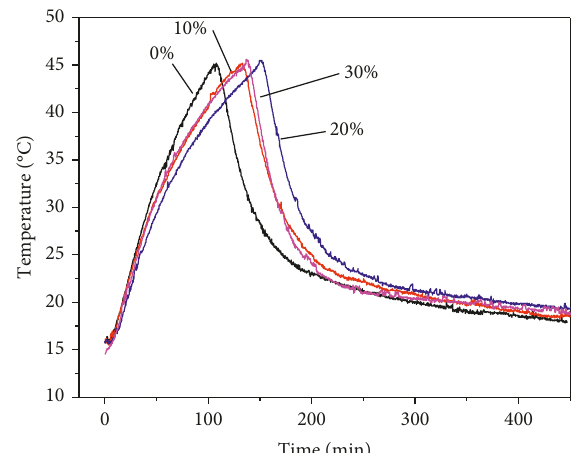
Figure 5: Thermal conductivity of gypsum boards with OD/EP materials.